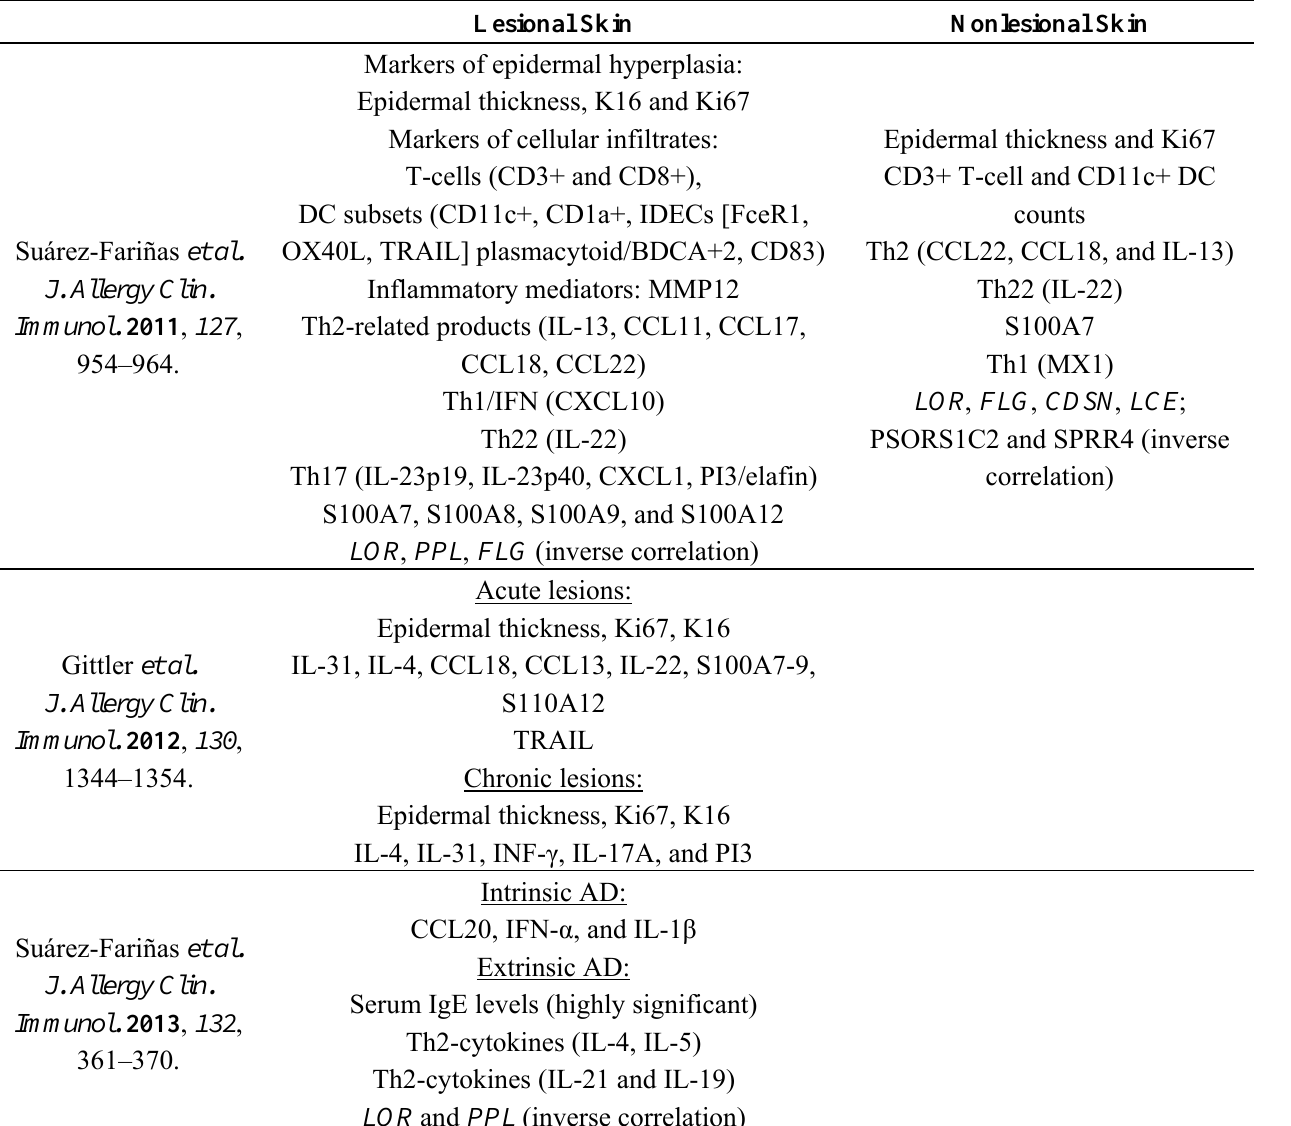
Table 1. Biomarkers of disease